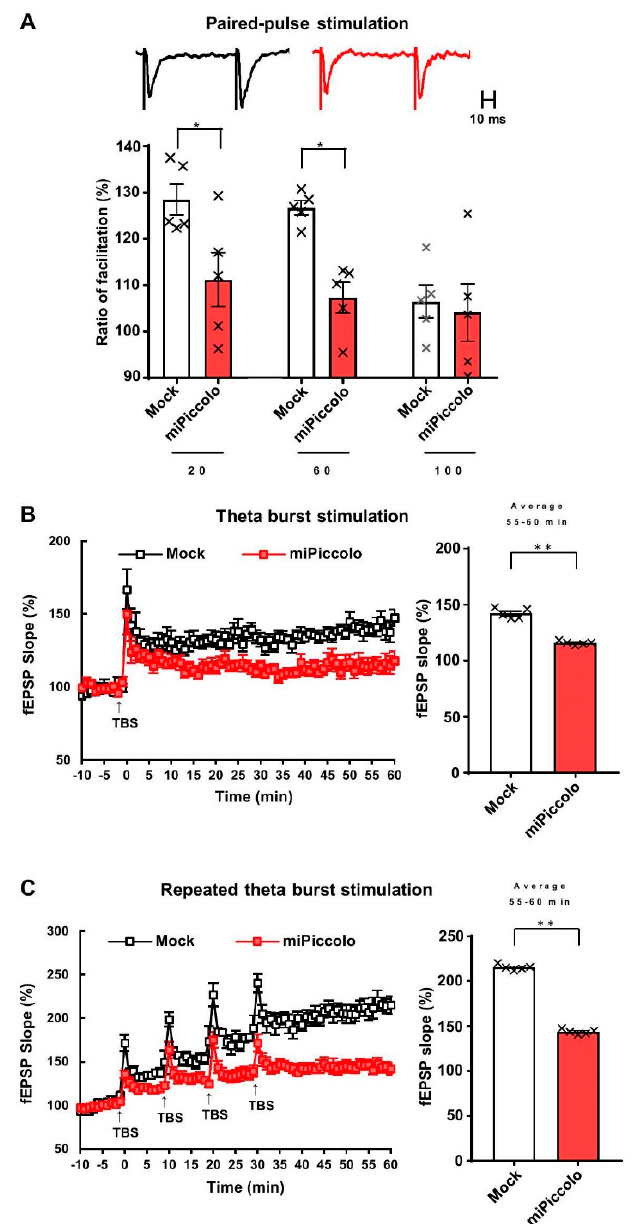
Figure 2. An electrophysiological analysis in the mPFC of miPiccolo mice. ( A ) Ratio of paired-pulse facilitation in the mPFC (n = 5). Representative slope pairs evoked with 60-ms interstimulus intervals are shown for the brain slice acutely prepared from the Mock and miPiccolo mice. * p < 0.05, ** p < 0.01 vs. Mock (Student’s t -test). ( B ) Left panel: Long-term potentiation (LTP) in the mPFC (n = 5). fEPSP: field excitatory postsynaptic potential, TBS: theta burst stimulation (TBS). Right panel: The potentiation rate was calculated by comparing the average slope 55–60 min after the TBS (n = 5). ** p < 0.01 vs. Mock (Student’s t -test). ( C ) Left panel: Saturation of LTP in the mPFC (n = 5). Right panel: The potentiation rate was calculated by comparing the average slope 55–60 min after the first TBS (n = 5). ** p < 0.01 vs. Mock (Student’s t -test). Next, LTP was examined in the mPFC. The suppression of Piccolo diminished LTP induction (average of 55–60 min, Student’s t -test, n = 6, p = 0.0055; Figure 2B, right panel). Repeated theta-burst stimulation was then used to determine the LTP saturation, which indicated the functional retention of synaptic modification. The Mock mice had greater LTP saturation than the miPiccolo mice (average of 55–60 min, Student’s t -test, n = 6, p =